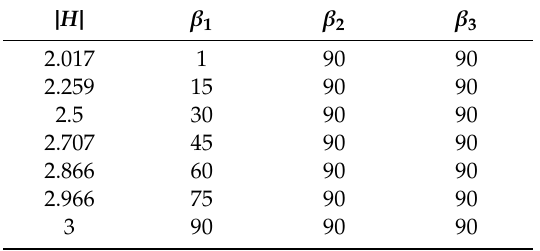
Skew angles measured in degrees.